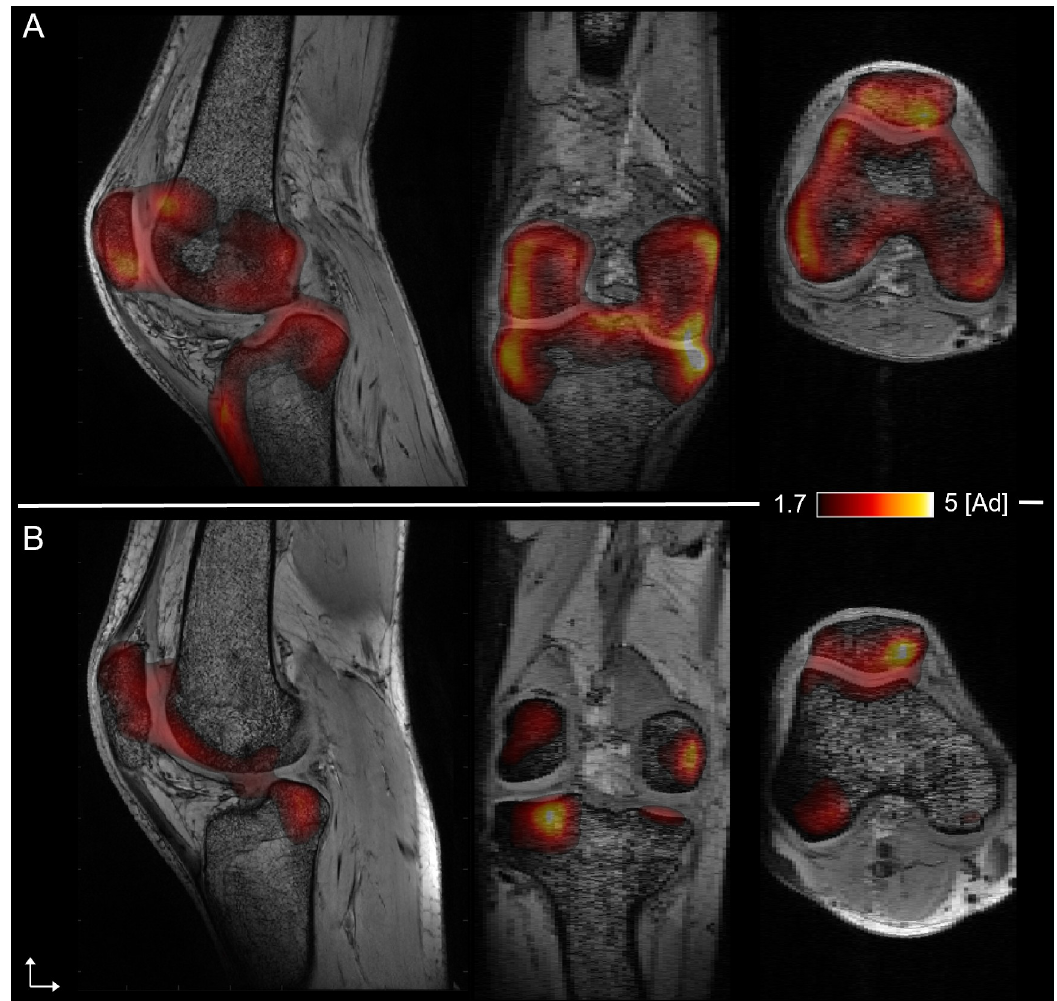
Fig 1. Merged PET-UHF MRI. Sagittal, coronal, and axial plane of merged PET-UHF MRI of the knee articulation of the patient before (A) and after (B) treatment by TNF-antibodies. “[Ad]” refers to a dimensional. Values higher or equal to 2.5 are considered indicative of “hypermetabolic”